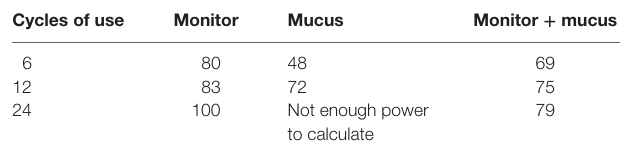
Table 3 | Correct use pregnancy rates (per 100 women) according to fertility